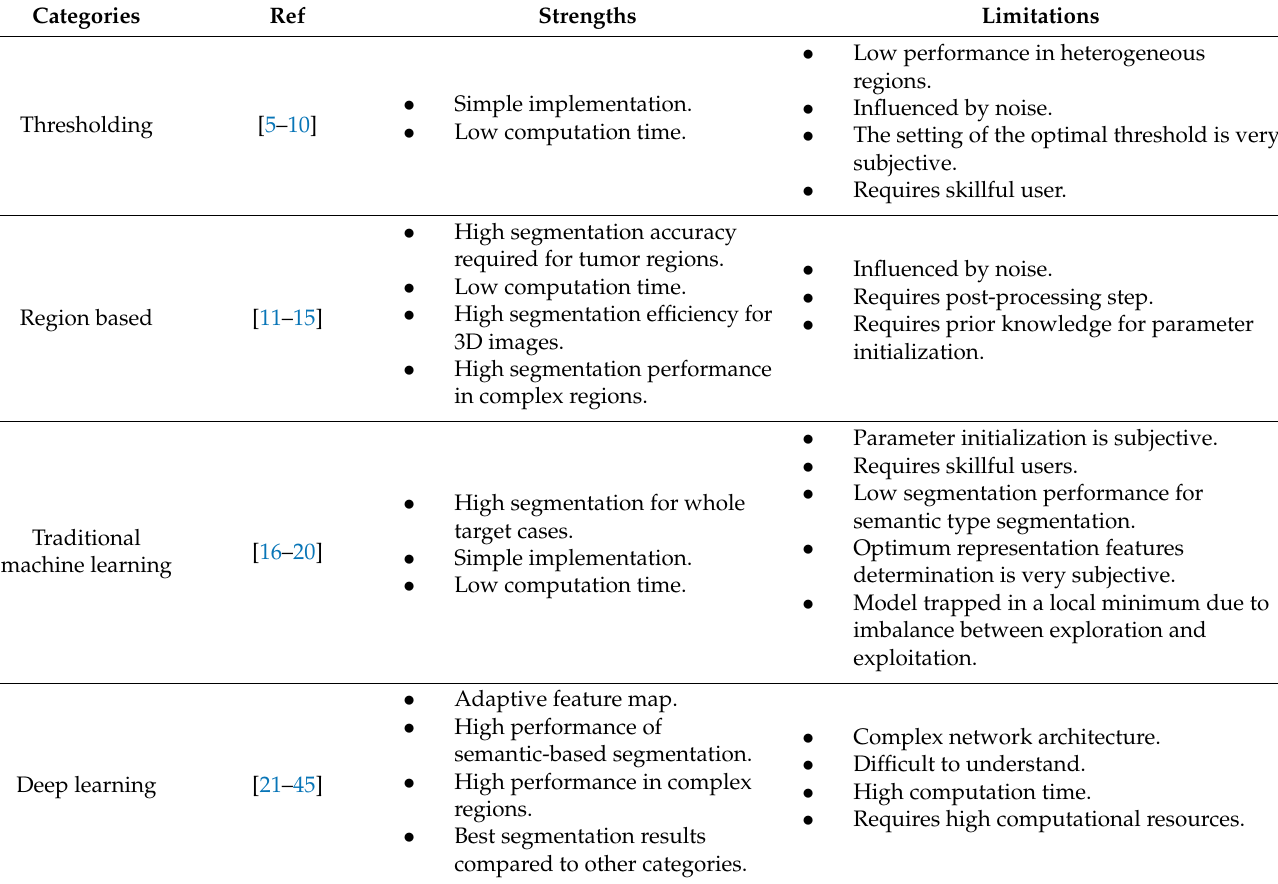
Table 1. Strengths and limitations of intensity-based and machine learning approaches for brain segmentation. Categories Ref